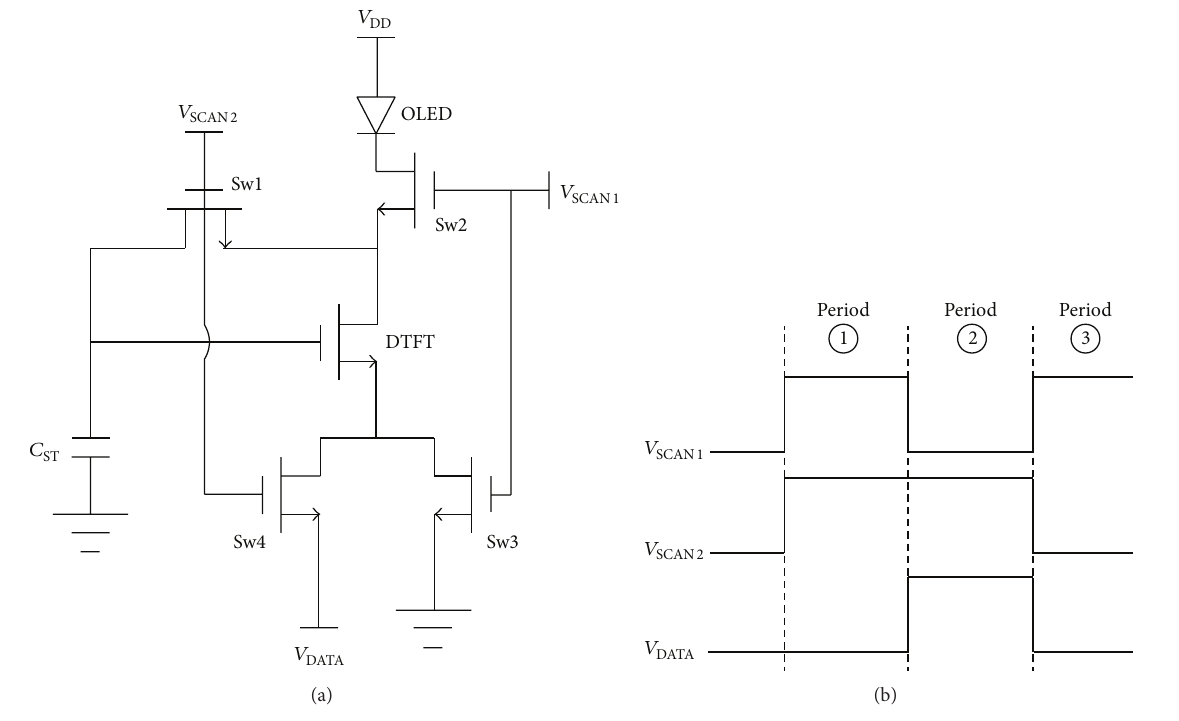
Figure 2: (a) Schematic diagram of the proposed pixel circuit and (b) its control-signal timing